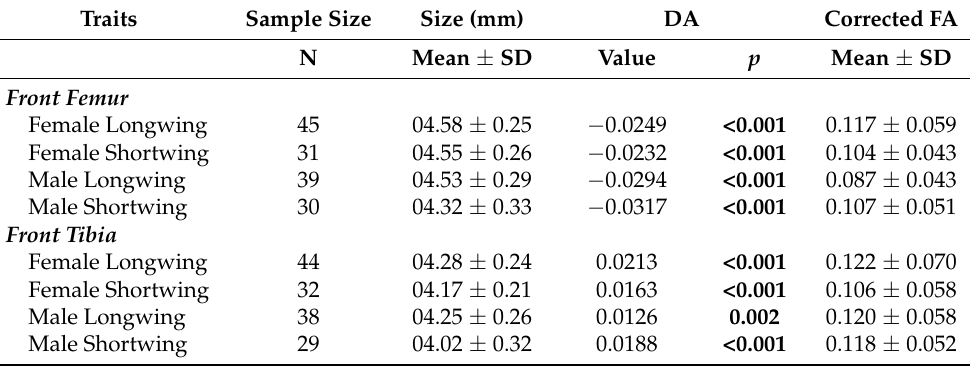
Table 2. Descriptive statistics of morphological variables. Significance of DA determined using a one-sample t -test and indicated by bolded